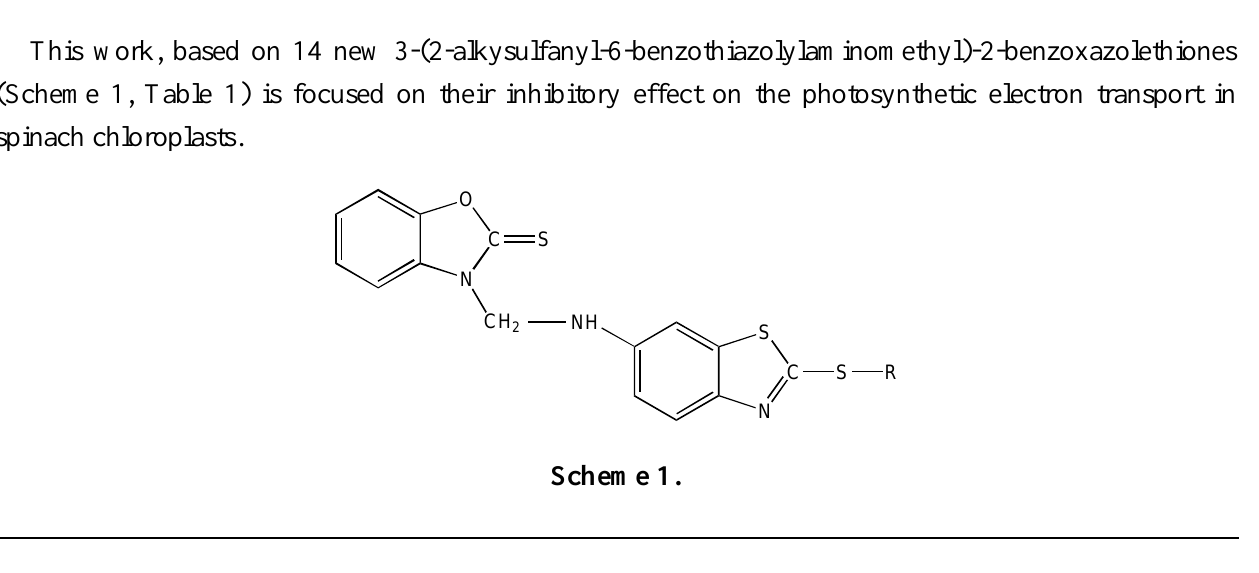
Table 1. Characterisation of the prepared